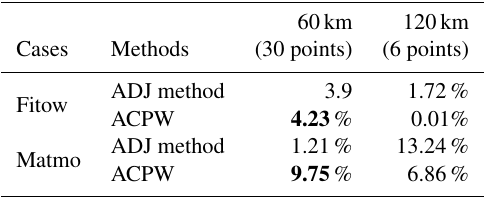
Table 7. Benefits (in %) gained from reducing the CNOPs by a factor of 0.5 in the sensitive regions identified by the ADJ method and the ACPW algorithm with 6 points at the 120km resolution and 30 points at the 60km resolution. The bold numbers represent the best values of the